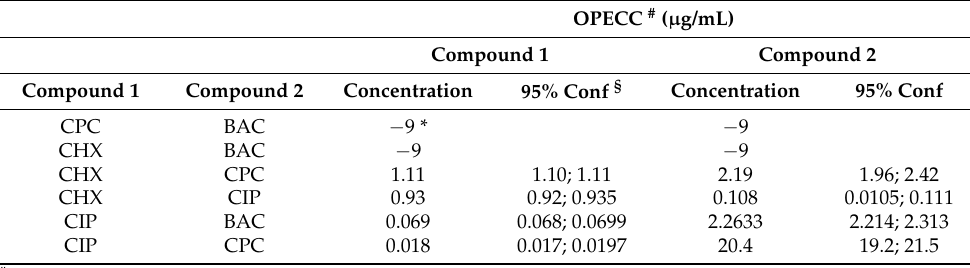
Table 3. OPECCs ( optimal effective concentration combinations ), including 95% confidence intervals, for binary combinations of the four tested compounds.